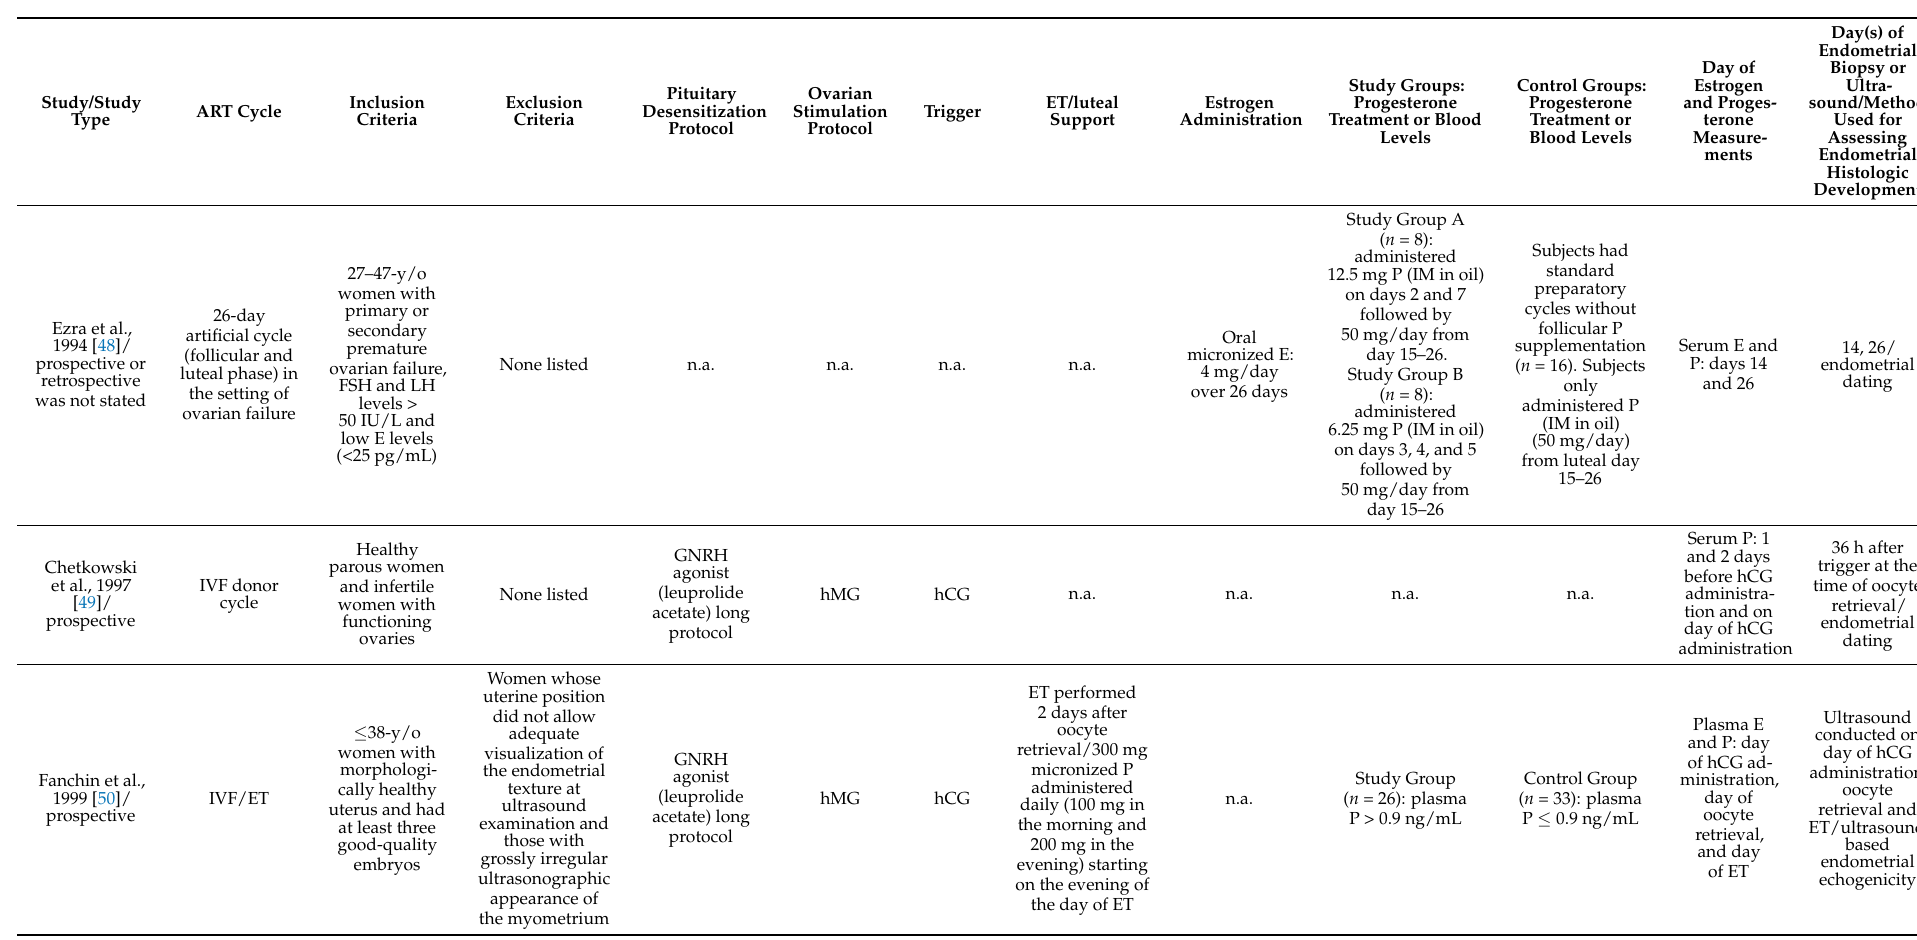
Table 1. Assessing the impact of progesterone levels on endometrial histological